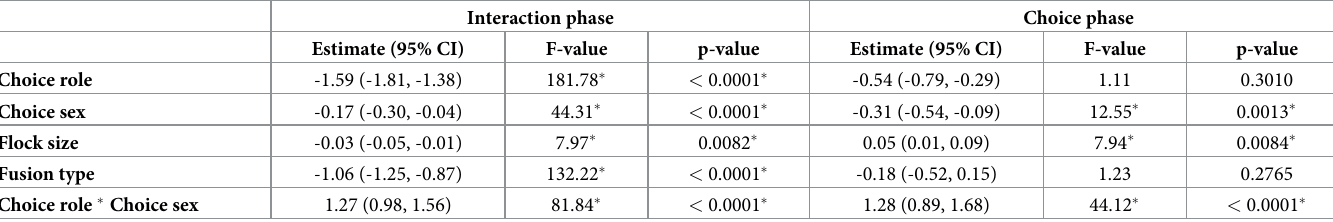
Table 2. Response rate results for male-female trials.